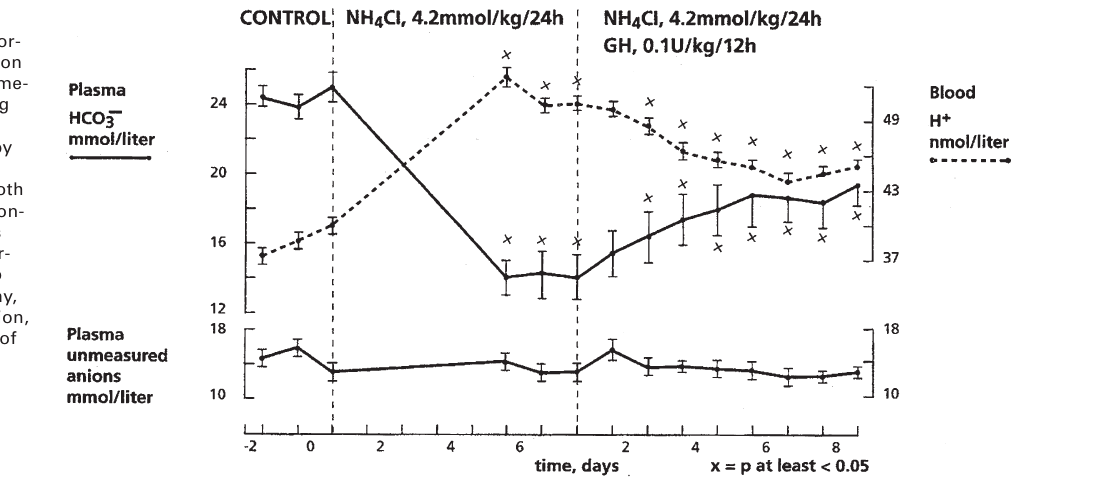
Figure 3 Effect of growth hor- mone administration on acid-base parame- ters in pre-exisiting chronic metabolic acidosis induced by NH 4 Cl ingestion in normal humans Both proton and bicarbon- ate concentrations return towards nor- mal in response to GH (01 U/kg bw/day, [10], with permission, American Society of